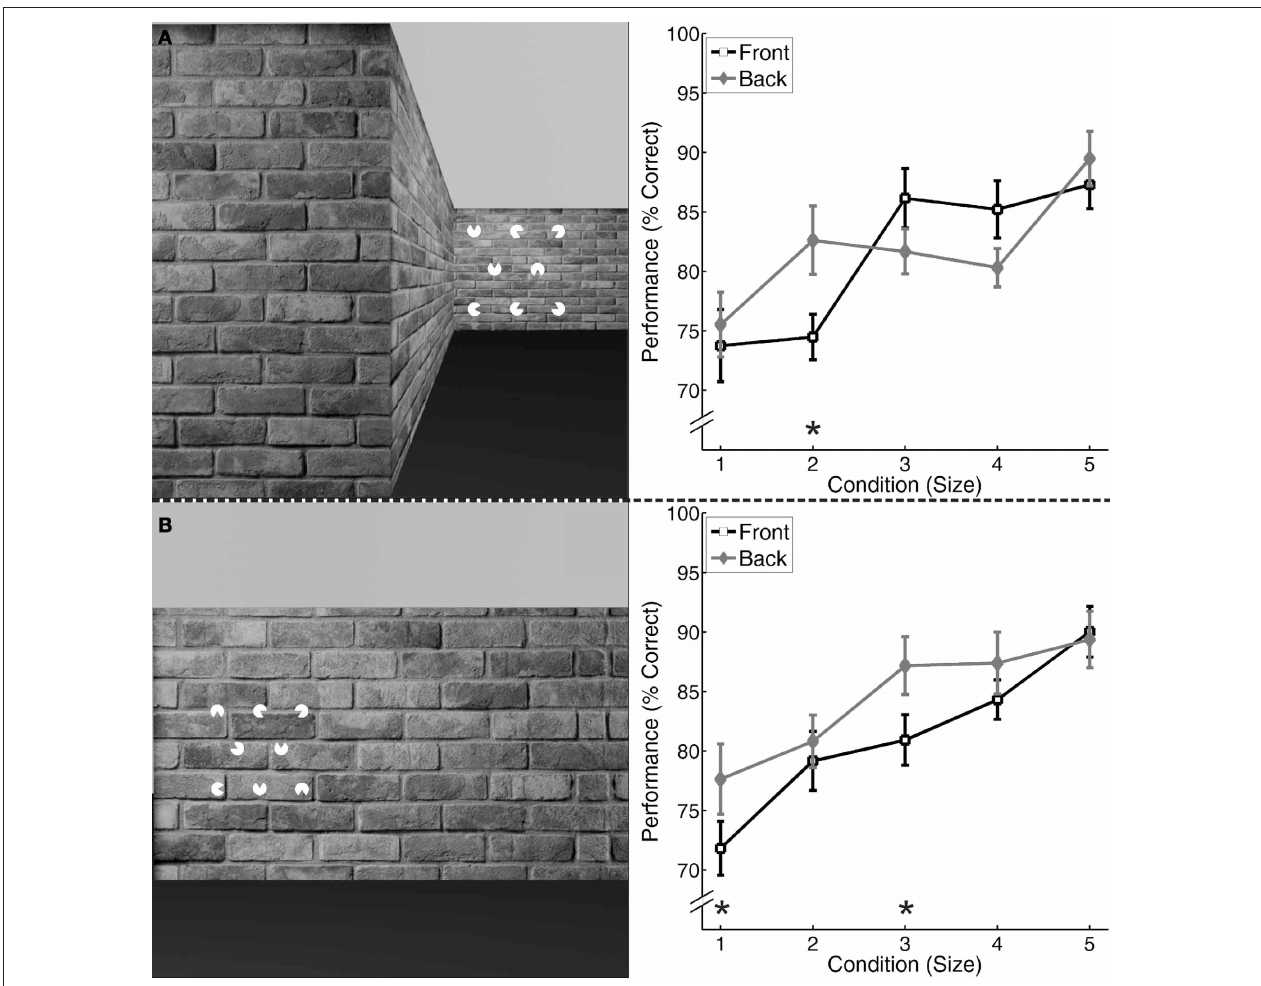
FIGURE 2 | Left: 3-2-3 array of white “pacmen” forming a “Kanizsa” triangle in one of four possible positions presented on one side of a shifted wall. (A) Stimulus for Experiment 1: 3-2-3 array presented on a naturalistic wall; (B) Stimulus for Experiment 2: 3-2-3 array presented on a wall appearing close (Front condition). The distant condition (Back) is not